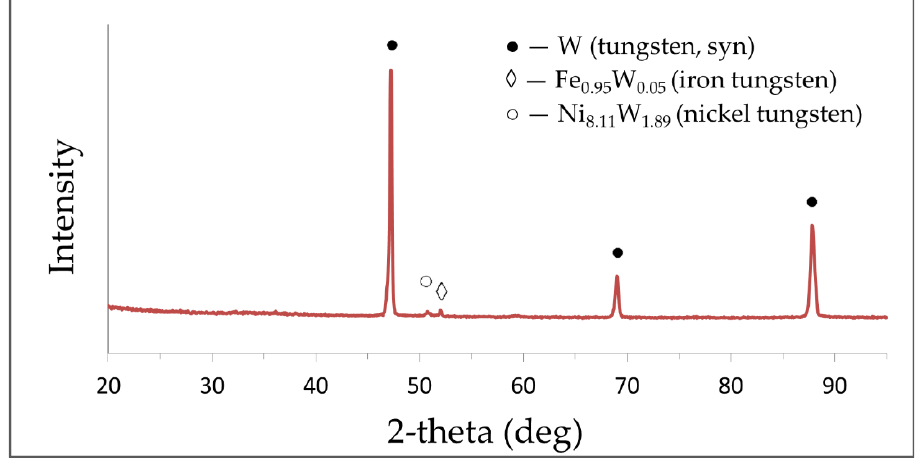
Figure 7. XRD diagram of W-Ni-Fe plasma spheroidized micropowder. Test specimens for studying the structure and physical and mechanical properties were processed from W-Ni-Fe powder by selective laser melting using the Realizer SLM 100 machine with a modernized 1000 W laser system. Basic parameters of SLM for W-Ni-Fe powder are provided in Table 1. Table 1. Operating parameters of selective laser melting of W-5Ni-2Fe powder.